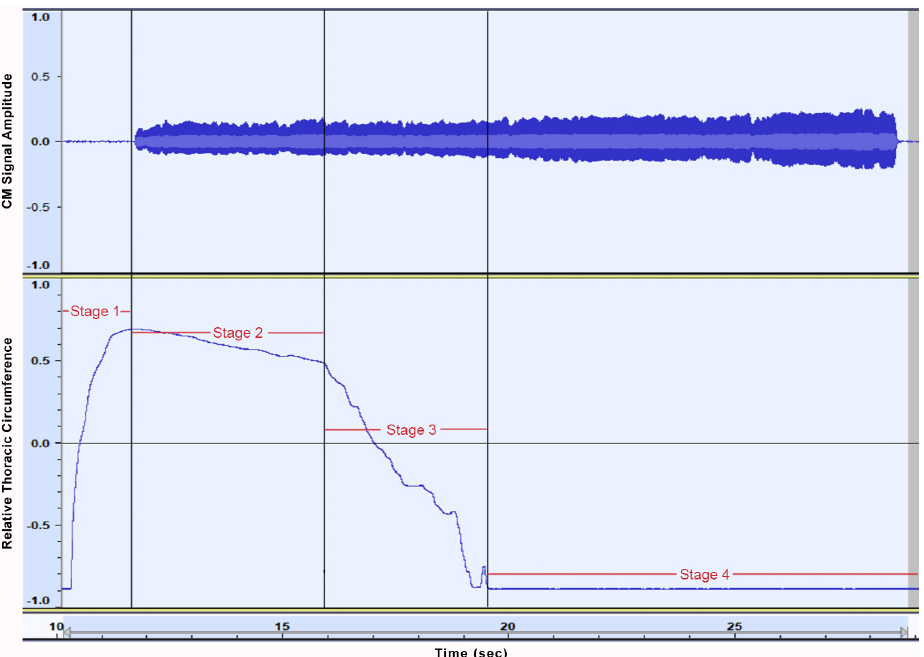
Figure 8. Graphic representation for the four distinct stages for thoracic movement during a typical phonation trial for Participant 1 (P1). Representations shown are for Condencer Microphone (CM) signal ( top ), and for thoracic region Respiratory Effort Transducer (RETt) ( bottom